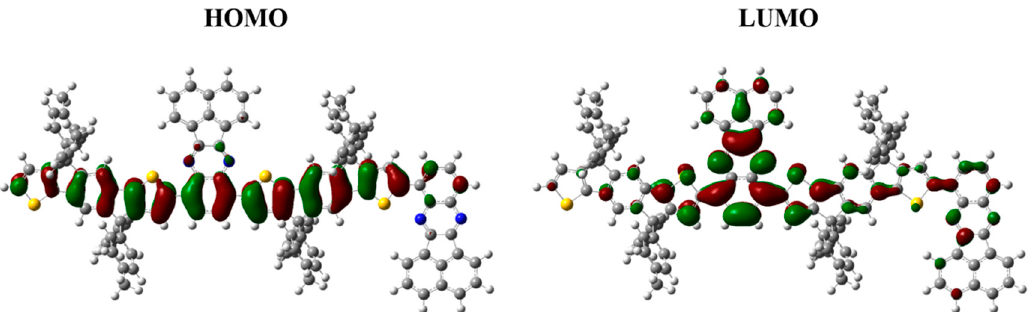
Figure 4. The HOMO and LUMO wave functions of PIDT-AQx.